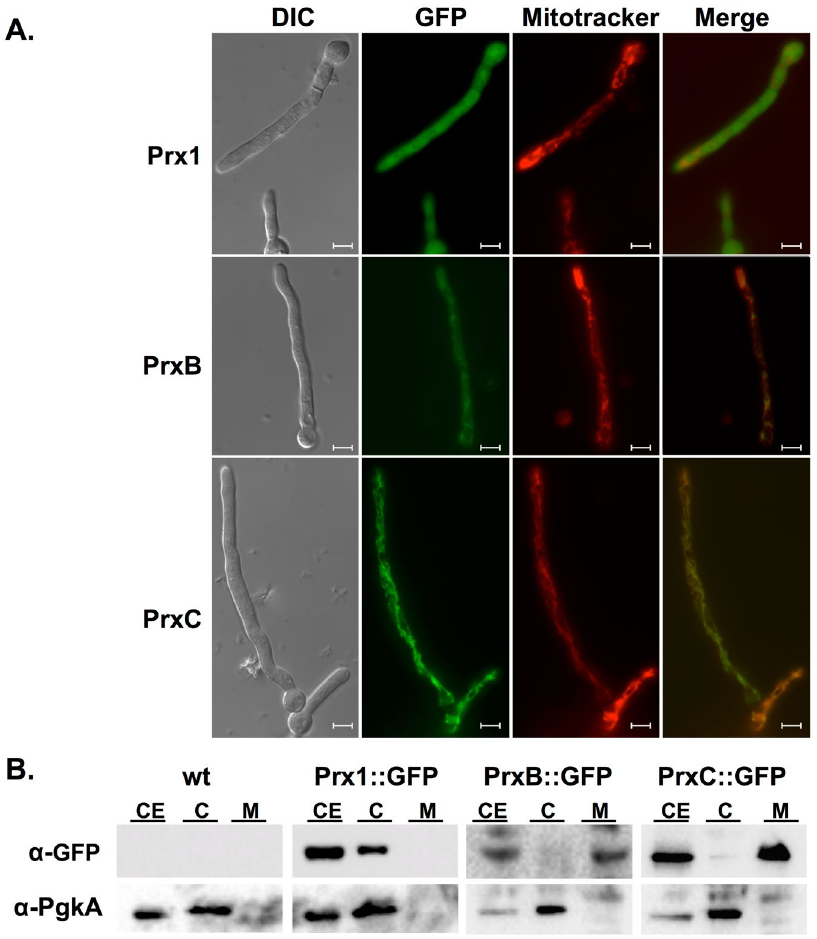
Figure 5. Prx1 localizes to the cytosol, while PrxB and PrxC are mitochondrial Prxs. ( A ) The Prx::GFP strains were grown for 16 h at 30 °C in MM, stained with Mitotracker, washed and directly inspected under the fluorescence microscope. Bars: 5 µ m. ( B ) Western blot of the cytosolic and mitochondrial fractions of the Prx::GFP strains. CE: crude extract; C: cytosolic fraction; M: mitochondrial fraction. Prxs were detected by using an anti-GFP antibody. An anti-PgkA antibody served as fractionation control. Experiments were repeated three times and a representative result is shown. In the figure are reported the cropped gels/blots obtained by each protein evaluation. All gels were run in the same experimental conditions. Full-length blots are presented in Supplementary Figure